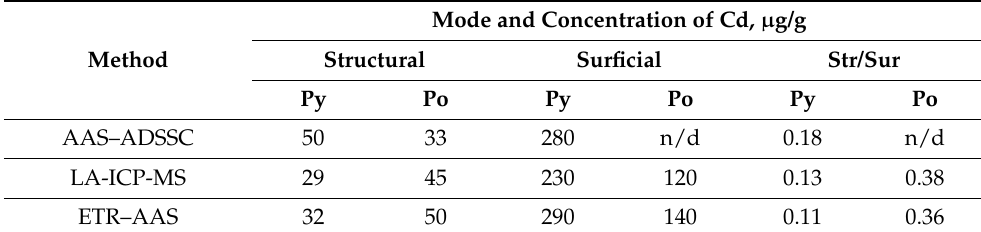
Table 4. Comparison of the results of Cd modes determined by different methods.